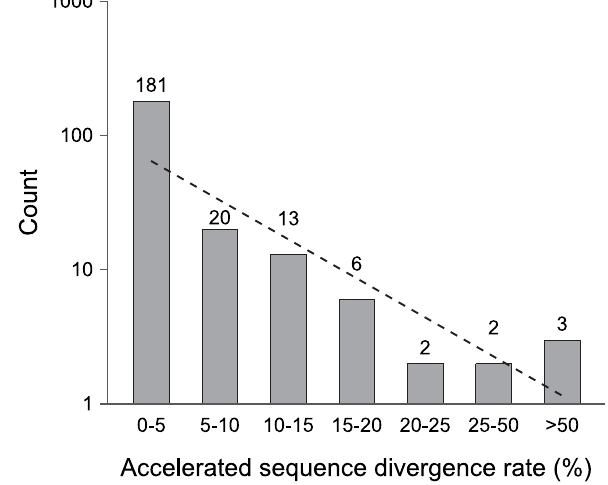
Figure 3. Pseudogenes classified by their acceleration in rates of sequence divergence. Two functional orthologs, one from the outgroup ( S. enterica subsp. arizonae ) and one from the nearest ingroup, were used in multiple sequence alignments to calculate the relative sequence divergence rate for each pseudogene. Numbers on top of columns indicate actual counts. The dashed line represents the neutral expectation based on an exponential regression.